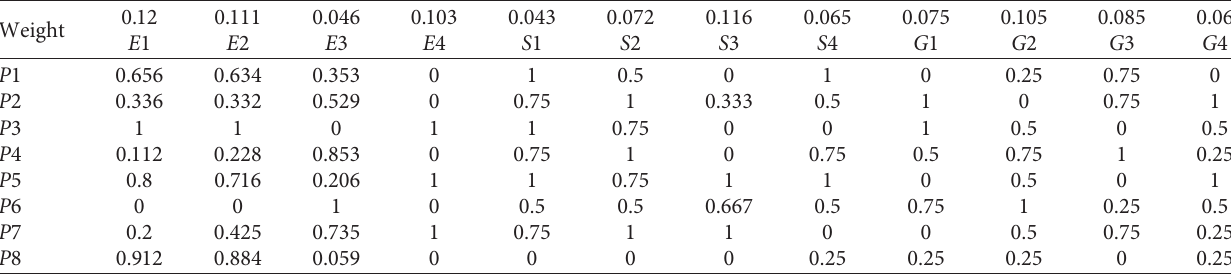
Table 32: Normalized decision matrix in deterministic condition.